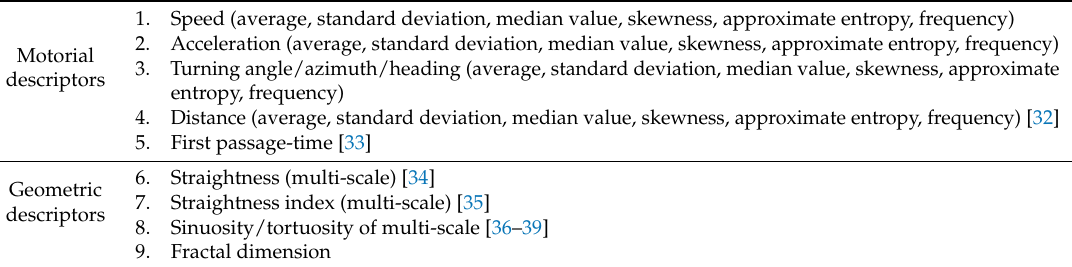
Table 2. The motorial and geometric descriptors for GPS trajectories.